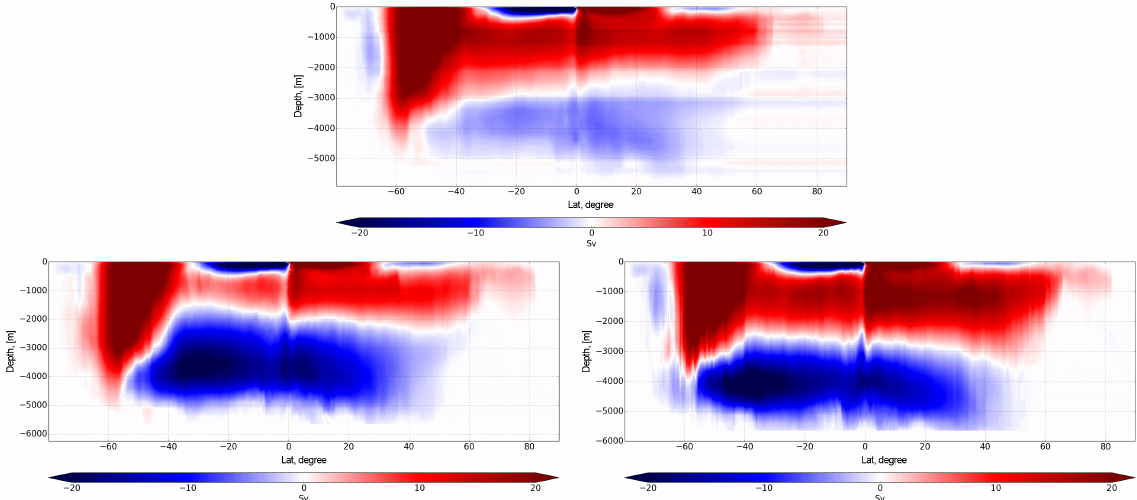
Figure 6. Eulerian-mean meridional overturning streamfunction averaged over the last 15 years of 60-year simulations for FESOM1.4 on the reference mesh (a) and FESOM2.0 on the reference (b) and Glob15 (c)